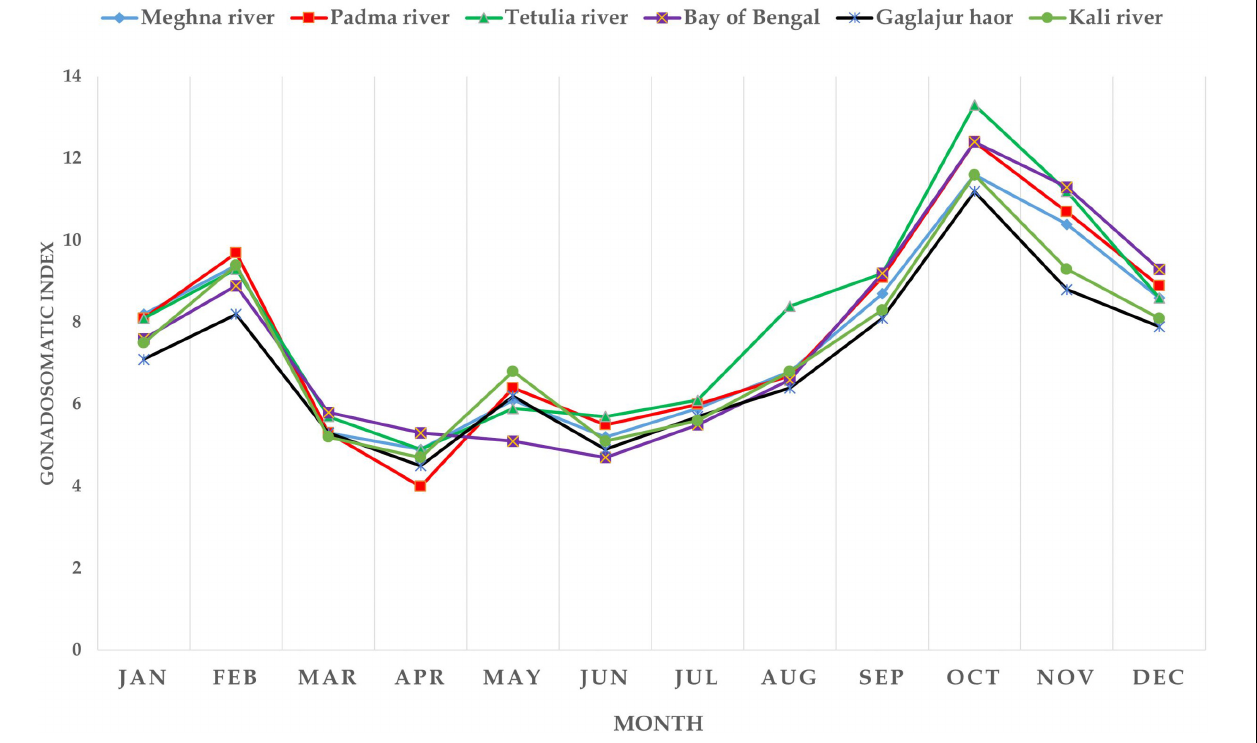
FIGURE 2 | Monthly representation of GSI of Hilsa collected from six different